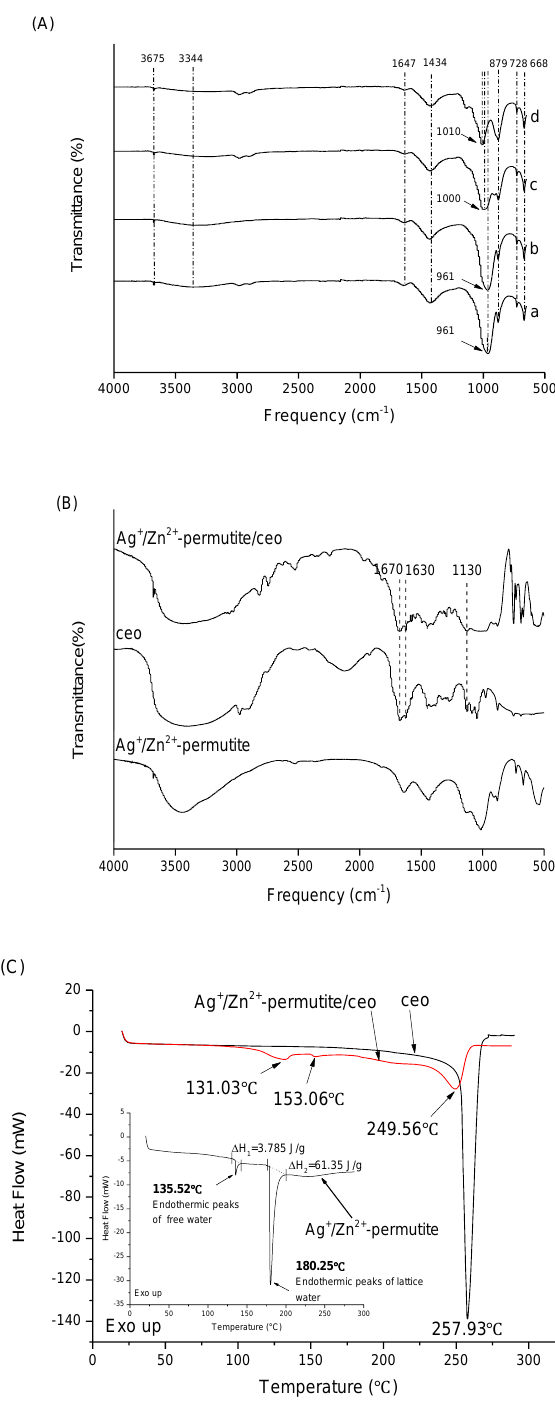
Figure 3. FTIR spectra ( A ) of ion-exchanged permutite: (a) permutite, (b) Ag + -permutite, (c) Ag + /Zn 2+ -permutite, (d) Zn 2+ -permutite; FTIR spectra ( B ) of Ag + /Zn 2+ -permutite/CEO; DSC curve ( C ) of permutite samples.